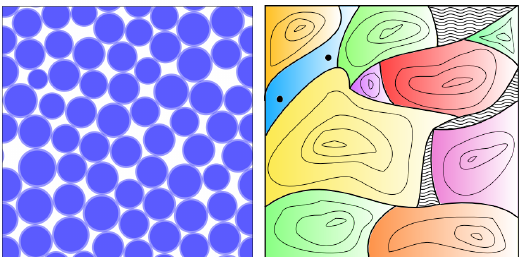
Figure 8: Energy landscape of hard-WCA particles. Left: Snapshot of jammed packing of polydisperse disks with hard cores (dark shaded) plus soft repulsive coro- nas (light shaded). Right: Illustration of configura- tional space for jammed packings. The hatched re- gions are inaccessible due to hard-core overlaps. Single- colored regions with contour lines represent the basins of attraction of distinct minima. Blue region with solid dots indicates the coexisting unjammed fluid region (observed only for finite size systems) and hypotheti- cal marginally stable packings. Figures adapted from Ref.